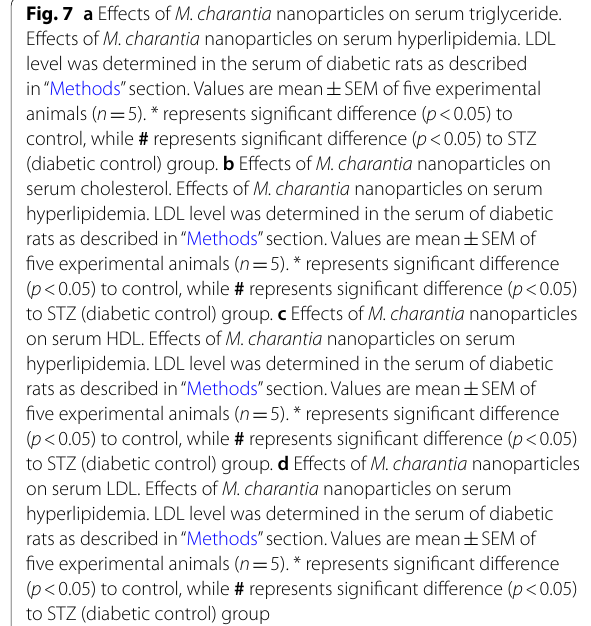
Fig. 7 a Effects of M. charantia nanoparticles on serum triglyceride. Effects of M. charantia nanoparticles on serum hyperlipidemia. LDL level was determined in the serum of diabetic rats as described in “Methods” section. Values are mean SEM of five experimental ± animals ( n 5). * represents significant difference ( p < 0.05) to = control, while # represents significant difference ( p < 0.05) to STZ (diabetic control) group. b Effects of M. charantia nanoparticles on serum cholesterol. Effects of M. charantia nanoparticles on serum hyperlipidemia. LDL level was determined in the serum of diabetic rats as described in “Methods” section. Values are mean SEM of ± five experimental animals ( n 5). * represents significant difference = ( p < 0.05) to control, while # represents significant difference ( p < 0.05) to STZ (diabetic control) group. c Effects of M. charantia nanoparticles on serum HDL. Effects of M. charantia nanoparticles on serum hyperlipidemia. LDL level was determined in the serum of diabetic rats as described in “Methods” section. Values are mean SEM of ± five experimental animals ( n 5). * represents significant difference = ( p < 0.05) to control, while # represents significant difference ( p < 0.05) to STZ (diabetic control) group. d Effects of M. charantia nanoparticles on serum LDL. Effects of M. charantia nanoparticles on serum hyperlipidemia. LDL level was determined in the serum of diabetic rats as described in “Methods” section. Values are mean SEM of ± five experimental animals ( n 5). * represents significant difference = ( p < 0.05) to control, while # represents significant difference ( p < 0.05) to STZ (diabetic control)